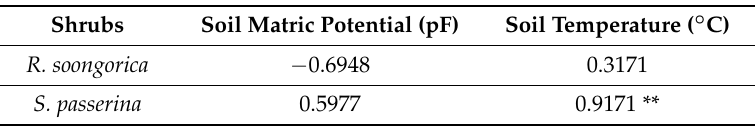
Table 6. Summary of correlations (Pearson) between the transpiration (mm d − 1 ) by Lysimeter measurement and the soil matric potential ( ψ m ) and the soil temperature (T soil ) at a depth of 0–40 cm during the experimental period.